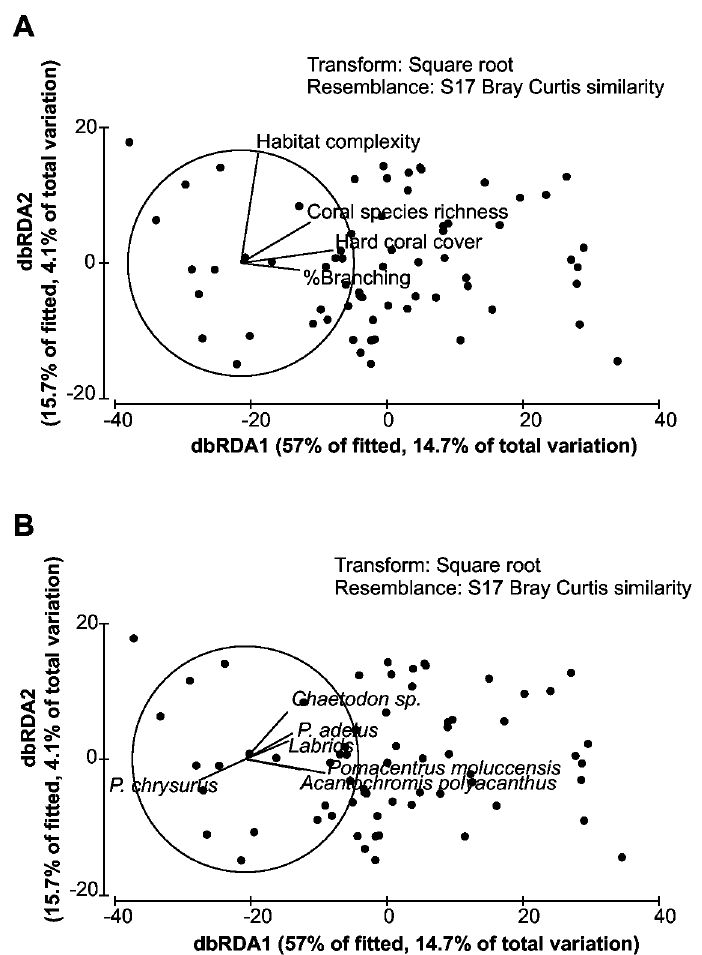
Figure 6. Fish community structure. Constrained distance-based redundancy analysis plot of fish community fitted to significant predictor variables (hard coral cover, habitat complexity, coral species richness, branching coral cover) identified using forward DistLM selection procedure and AIC selection criteria (Table 4). The relative influence of fitted predictor variables is indicated by the length of vector overlays. Each black point represent a single sample. a . Fitted predictor variables. Significant variable are identified with an asterisk (*) b . Fish species